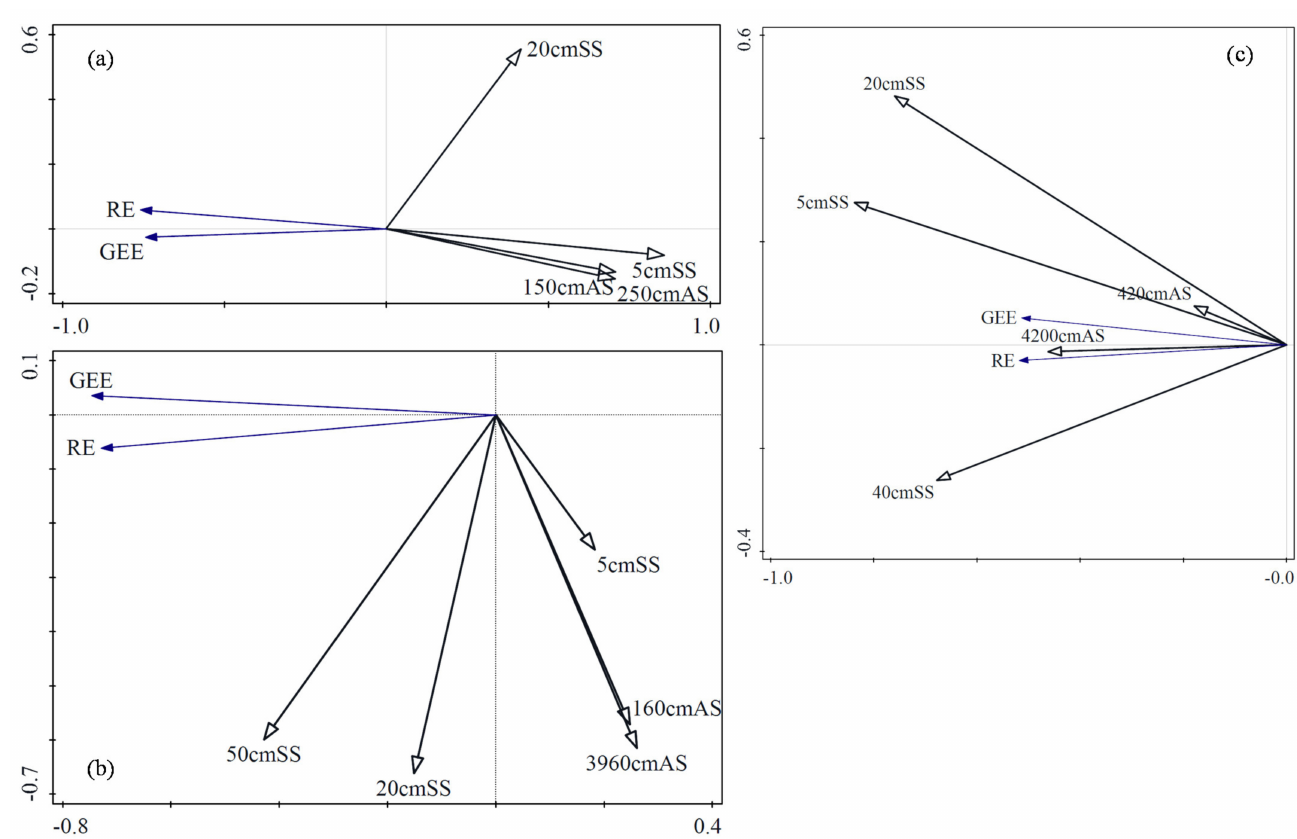
Figure 4. Redundancy analysis of moisture with ecosystem respiration and gross ecosystem exchange in temperate grassland ( a ), subtropical artificial coniferous forest ( b ), and tropical rain forest ( c ). Note: RE is ecosystem respiration, GEE is gross ecosystem exchange, AS is air moisture, SS is soil moisture, the number in front of SS and AS is the distance from the